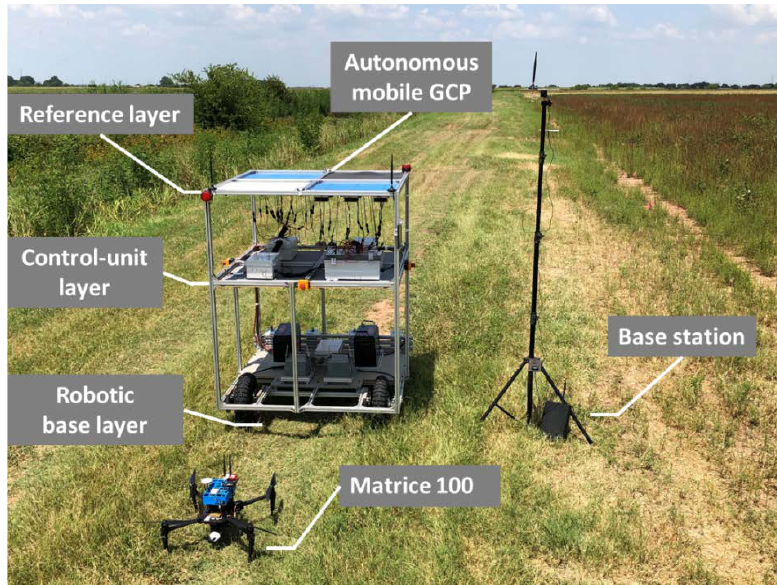
Figure 1. Individual components of the improved accuracy remote sensing system that comprises an autonomous mobile GCP, the Matrice 100 UAV, and a base station.